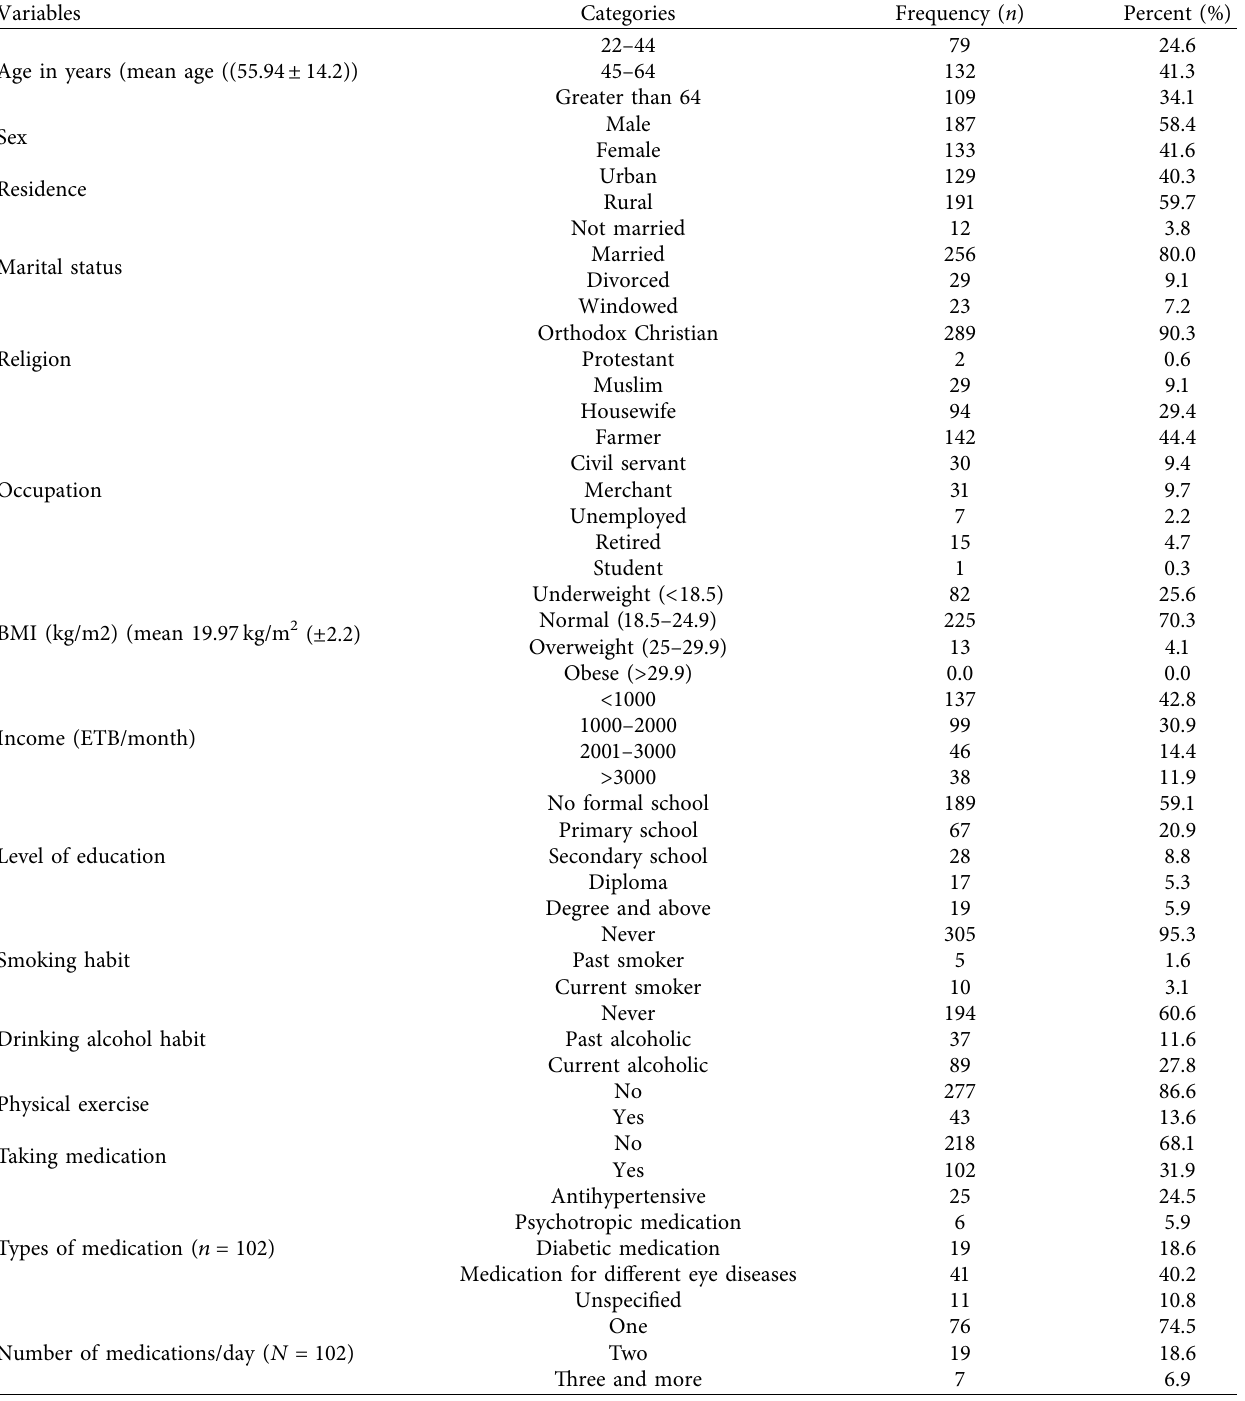
Table 1: The sociodemographic characteristics of the study participants, Gondar, Ethiopia ( n � 320).